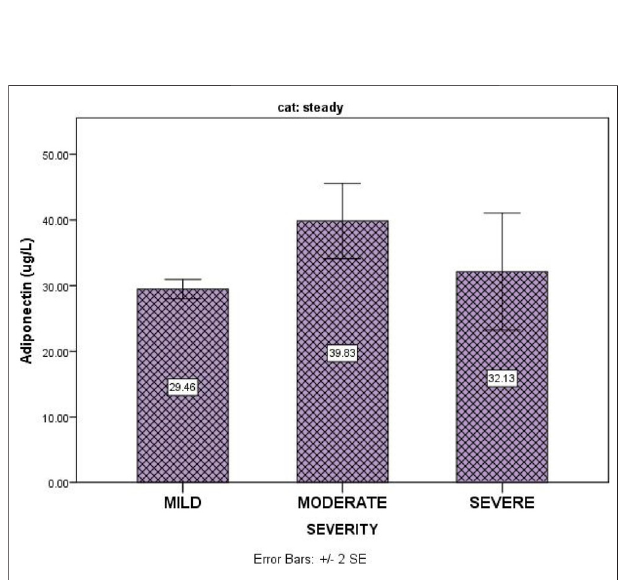
FIGURE 1 | SCD severity in the steady state versus adiponectin